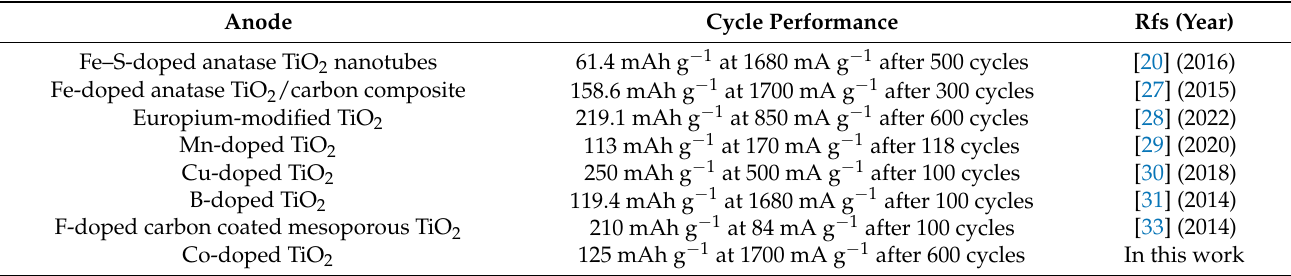
Table 1. The comparison of different doped TiO 2 as anode for LIBs.